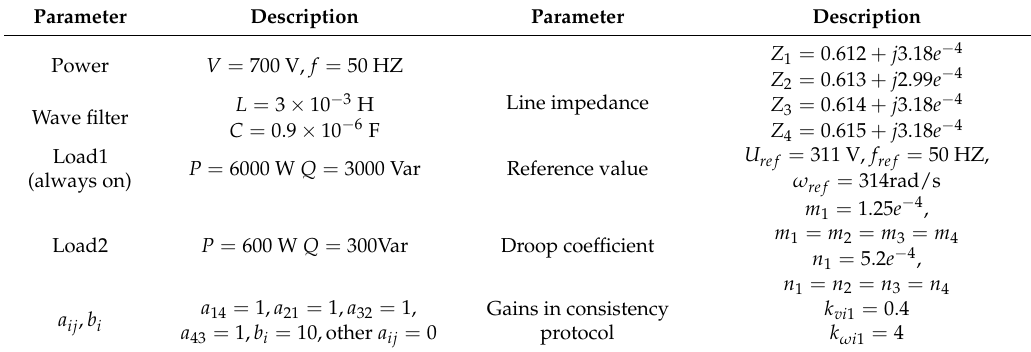
Table 1. Experiment parameters.